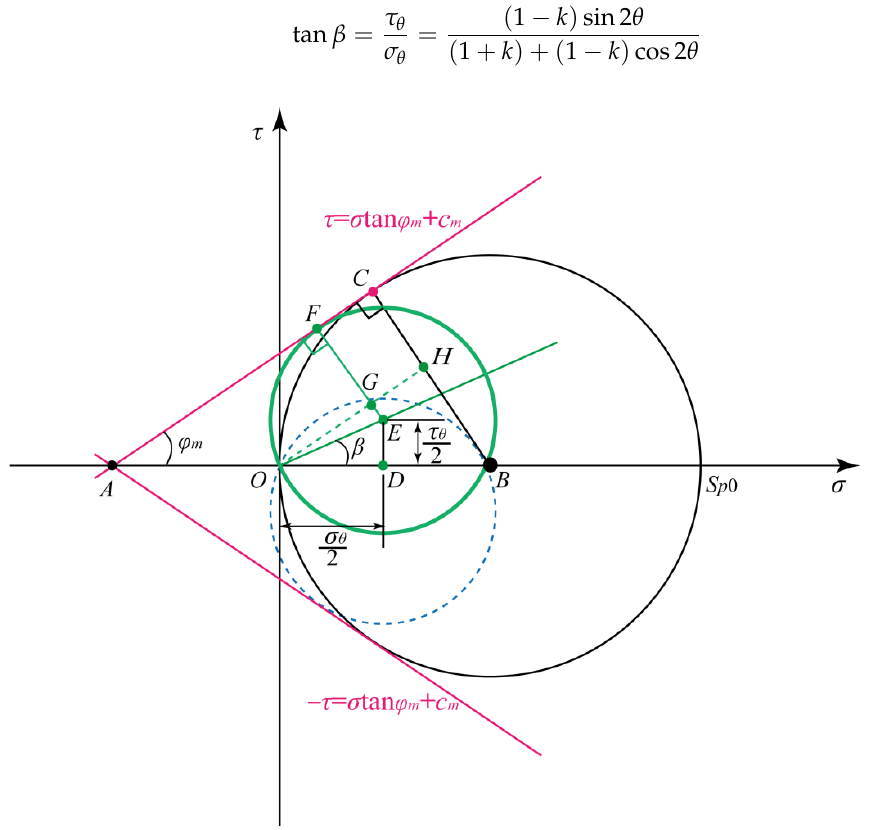
Figure 8. The relationship between the generalized Mohr circle and the strength envelope. Compared with the vertical pillar, the inclined pillar is additionally affected by shear load. The ratio of the shear strength of the inclined pillar to the strength of the vertical pillar is called the contribution factor of shear load ( CFSL ), which is represented by the symbol f